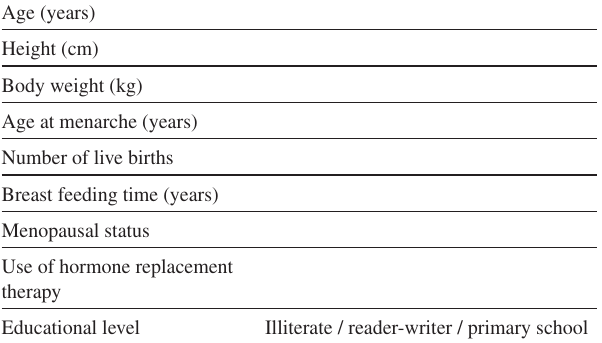
Table 2 - Continuous variables of osteoporosis risk factors